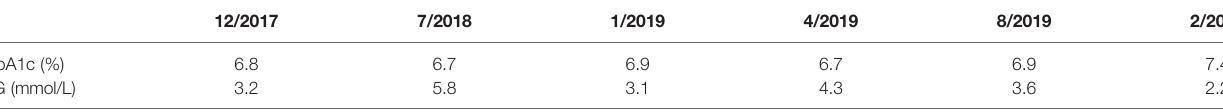
TABLE 1 | Serial HbA1c and fasting glucose levels in the past 3 years prior to the clinical